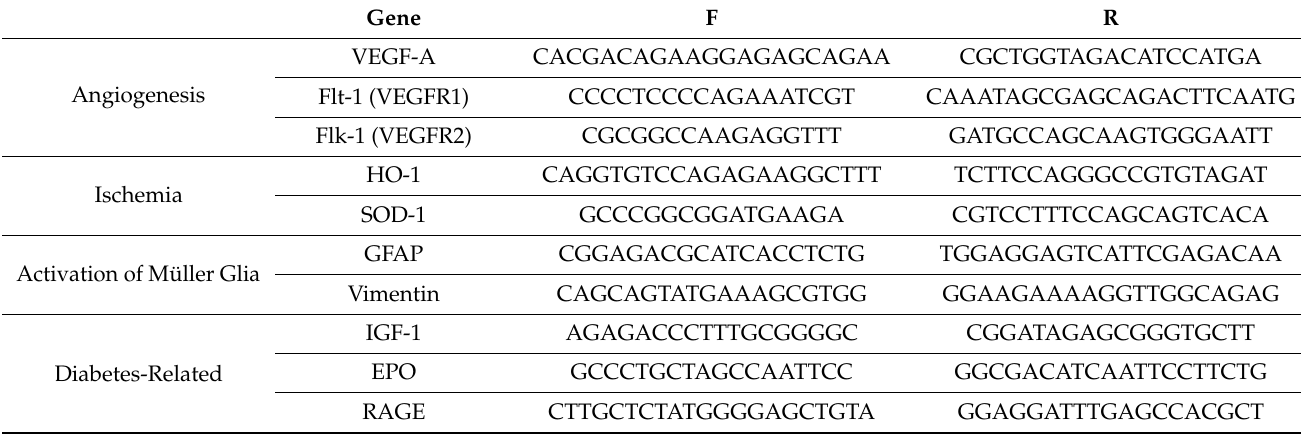
Table 1. List of primers used for RT-PCR analysis.